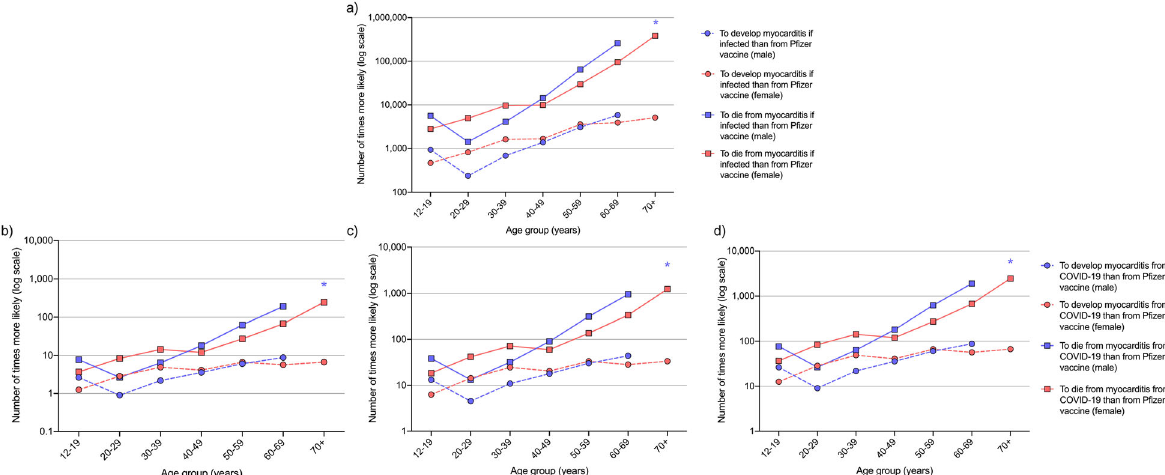
Fig. 2 Comparison of the estimated risks of developing and dying from P fi zer vaccine-associated or COVID-19-related myocarditis. Number of times more likely (in log scale) for each age-sex subgroup to develop (circles) and die (squares) from myocarditis ( a ) in patients with symptomatic COVID-19 than from P fi zer vaccine-associated myocarditis. In those not yet infected with SARS-CoV-2, estimates for developing and dying from myocarditis over a 2-month period if 5% of population of ages ≥ 12 years had no doses, 5% had fi rst dose, 60% had two doses (evenly distributed over 0 to < 2, 2 to < 4 and 4 to < 6 months since second dose) and 30% had three doses of P fi zer COVID-19 vaccine if community transmission equivalent to ( b ) 1%, ( c ) 5% and ( d ) 10% chance of infection over 2 months. *For males aged ≥ 70 years, P fi zer vaccine-associated myocarditis had an incidence of 0%. Note difference in y-axis scale between panel a and other